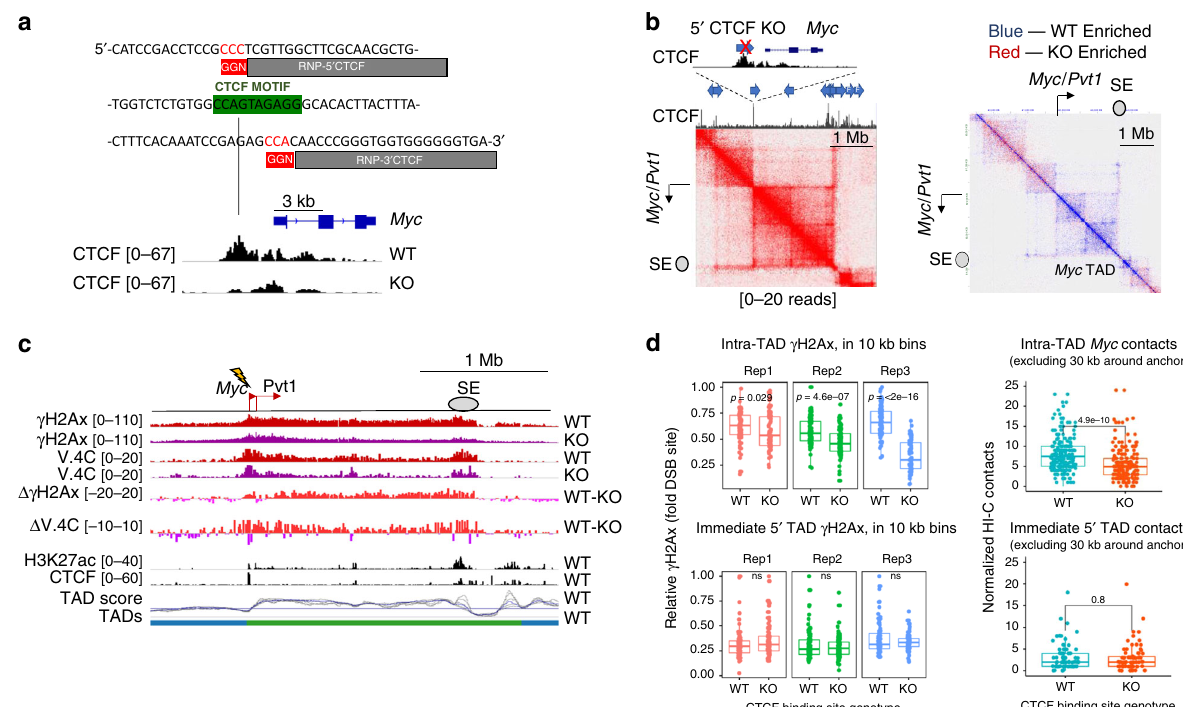
Fig. 4 CTCF is necessary for robust γ H2Ax propagation in the Myc -TAD. a CTCF motif deletion within a TAD border upstream of Myc . Top: Sequence of the upstream Myc -CTCF (green) and RNP target sites (gray and red). RNPs labeled 5 ′ and 3 ′ CTCF were used for deletion. Bottom: Myc locus in 5 ′ CTCF WT or KO pre-lymphocyte cells (63 – 12). Myc exons and UTRs are shown (top). Tracks represent CTCF CR-seq values (black, RPKM, n = 1) and the arrow indicates the CTCF motif. b Interactome of 5 ′ CTCF KO cells. Top left insert shows CTCF ChIP-seq data (0 – 60 RPKM, n = 1), CTCF motif orientation (blue arrows), TAD border, and deletion site (red X). Bottom: JuiceBox Hi-C plots show the wild-type Myc locus (left) or relative Hi-C interactome changes following CTCF deletion (right) ( n = 1, each). Blue points are ≥ 2 interaction counts higher in WT; red points are ≥ 2 counts higher in the 5 ′ CTCF KO. The location of the Myc -TAD is indicated on bottom. c UCSC snapshot, as described in Fig. 2, showing the Myc locus in 63 – 12 cells with and without the 5 ′ CTCF binding motif (representative of three independent results). For subtraction plots of γ H2Ax or V.4C data, red represents WT enrichment, while purple represents KO enrichment. d Myc promoter interactome and γ H2Ax derived from 5 ′ CTCF WT or KO cell lines, quanti fi ed in 10 kb bins across either the Myc -containing TAD or immediate 5 ′ TAD. Left: γ H2Ax 2 h after 5 ′ CTCF WT or KO cells were nucleofected with RNP Myc -P. Each γ H2Ax dataset was fi rst normalized to RPKM values at the DSB-containing bin. Colors represent biologically independent replicates ( n = 3). Right: Comparison of Myc promoter interactomes, derived from Hi-C data, across the Myc -containing TAD or immediate 5 ′ TAD in cells of indicated genotypes, without RNP nucleofection. Relative interactome measurements have been normalized using coverage normalization. For all plots, statistical enrichment (two-sided Paired Student ’ s t test) is shown above. Non-signi fi cant (ns) p values are 0.6, 0.27, and 0.26 for replicates 1, 2, and 3, respectively. Means, quartiles, and outlier limits (1.5 × interquartile range) are indicated by the median line, box and whiskers,